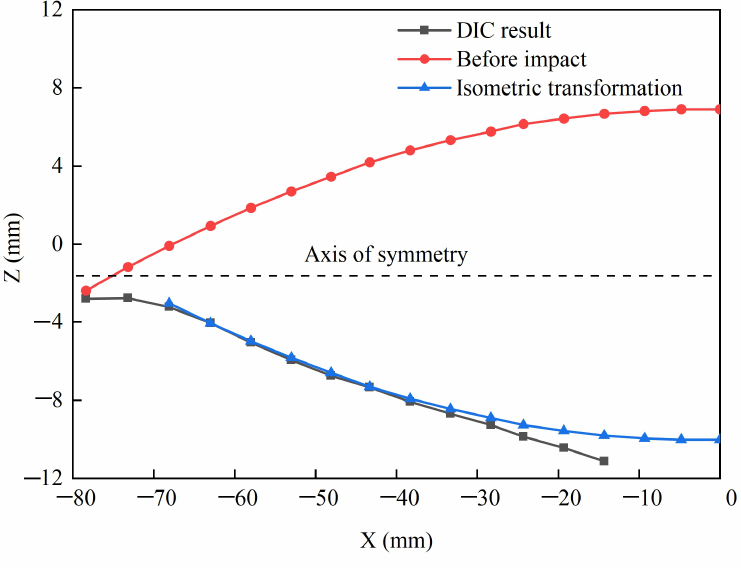
Figure 8. Validation of isometric